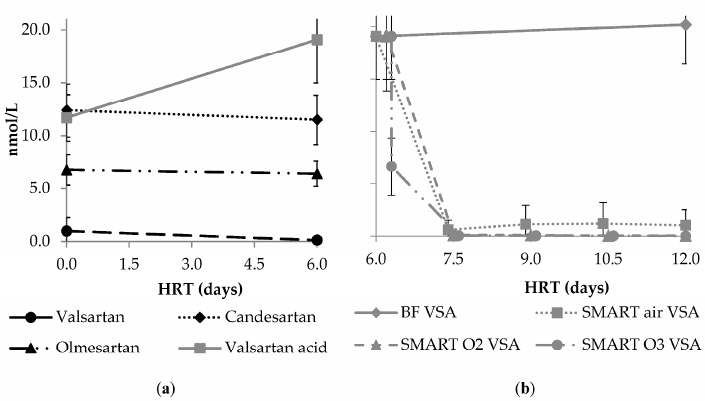
Figure 7. The formation of valsartan acid (VSA) in the first filtration step (grey line, a ) and the transformation of valsartan, candesartan and olmesartan (black lines, a ). Valsartan acid was degraded in the second filtration step after aeration with air, oxygen or ozonation ( b ) n ≥ 4.